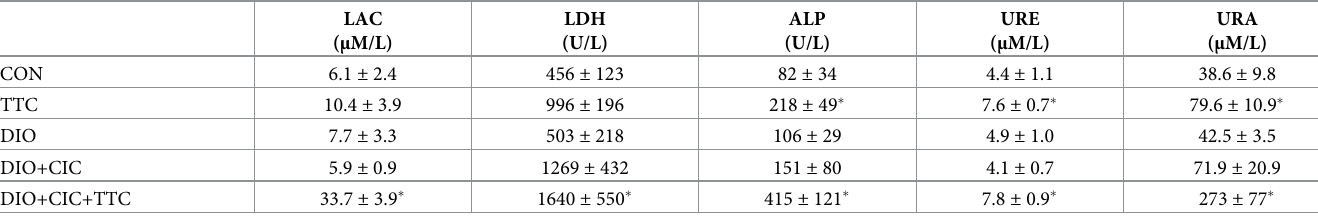
Table 1. Biochemical serum markers in Wistar rats at the end of the experiment. The results show mean values and standard deviations.